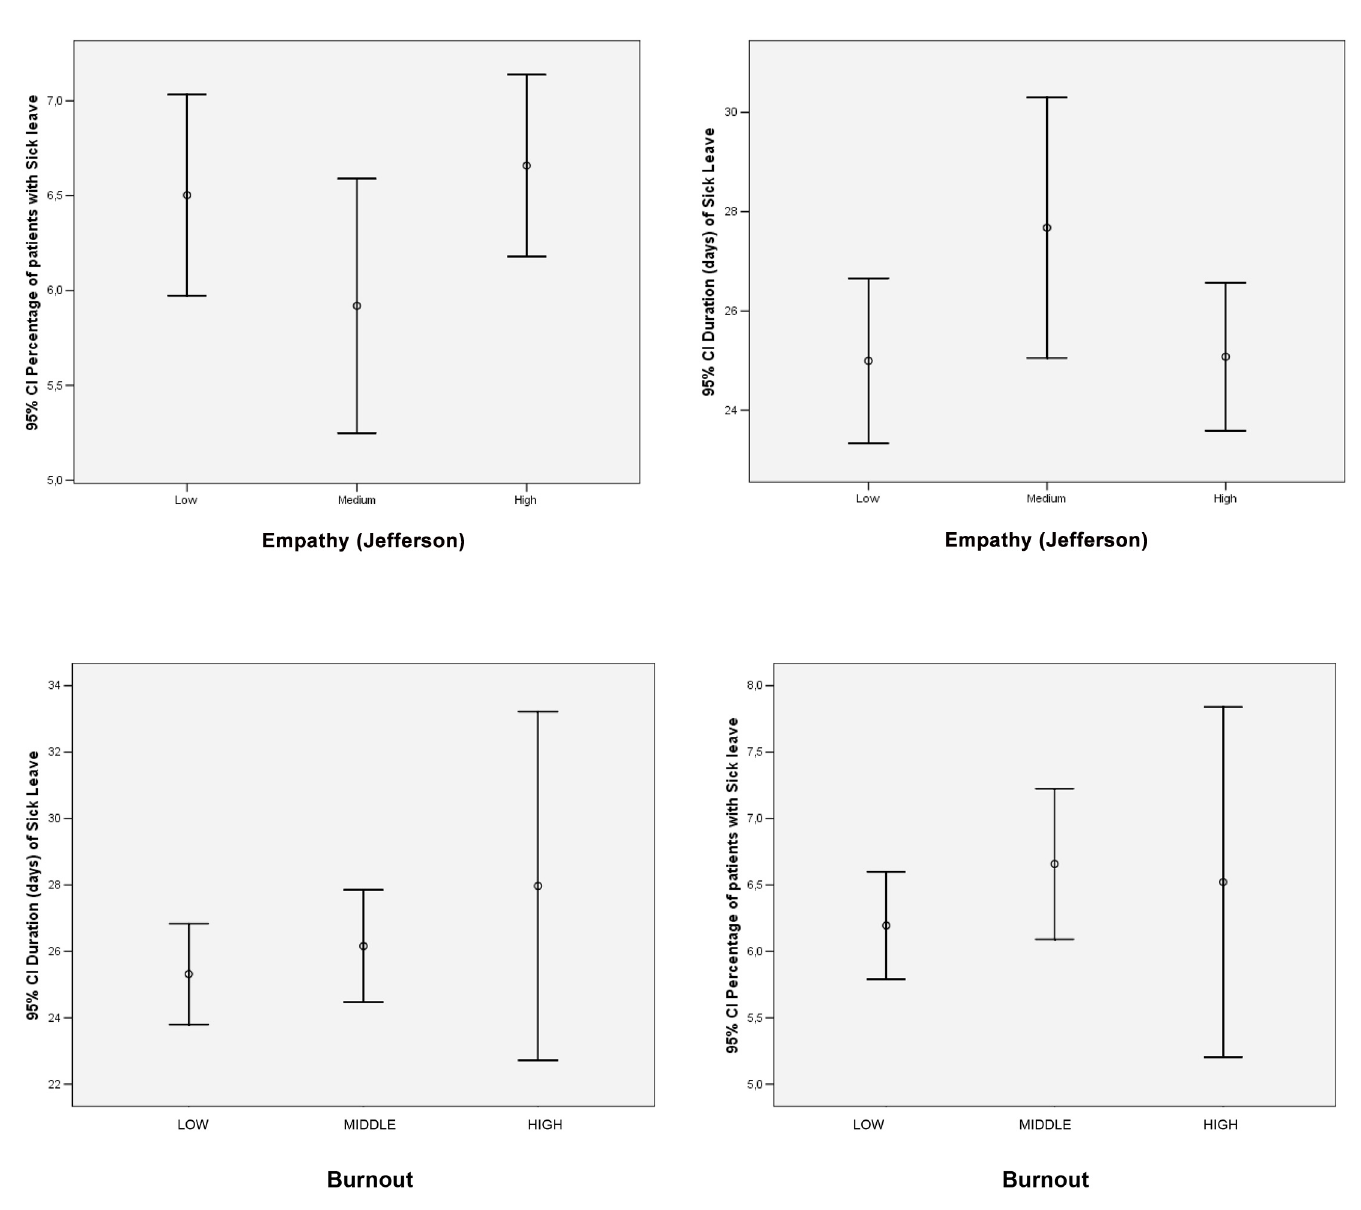
Fig 1. Association between burnout and empathy and sick leave prescription and